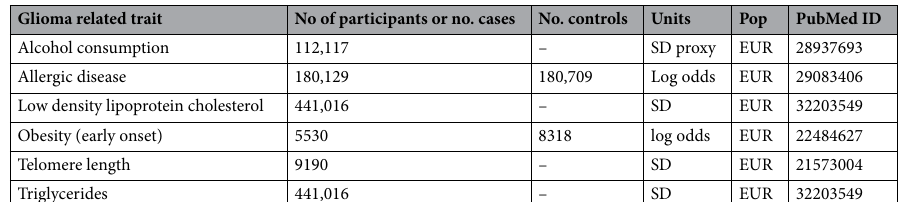
Glioma related trait No of participants or no. cases No. controls